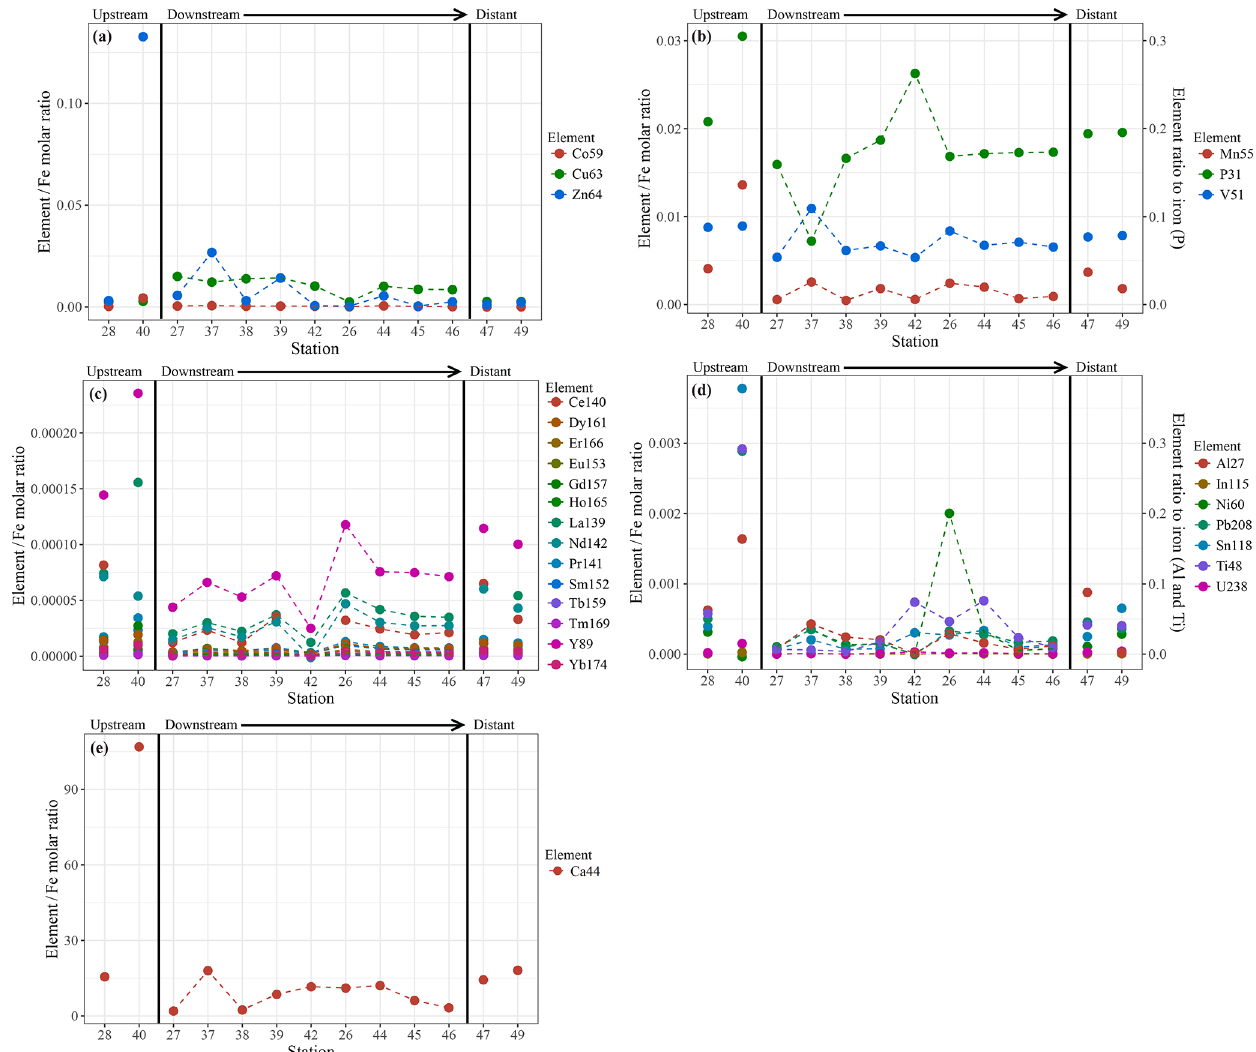
Figure 7. Element to iron molar ratios of plume samples of upstream, downstream and distant stations. Downstream stations follow the main path of the plume. (a) shows the element / Fe molar ratios of the chalcophiles (Co, Cu and Zn), (b) shows the ratios of Mn and the oxyanions (P and V), (c) displays the ratios of REEs, (d) the ratios of Al, In, Ni, Pb, Sn, Ti and U and (e) shows the Ca / Fe molar